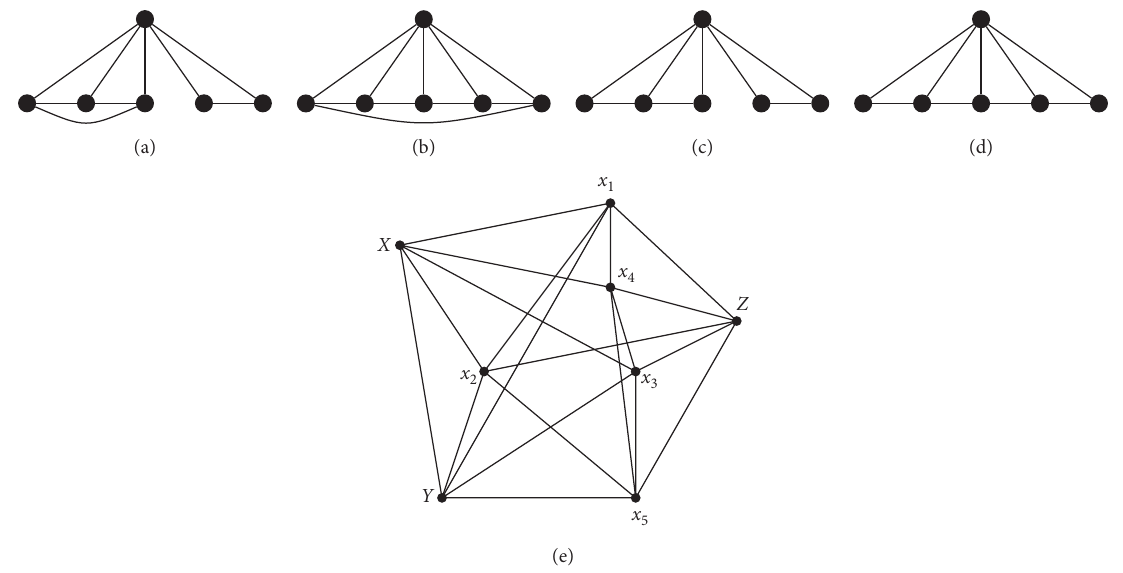
Figure 1: The local structure induced by a neighborhood of a vertex: (a) Type 1, (b) type 2, (c) type 3, (d) type 4, and (e) G ∗